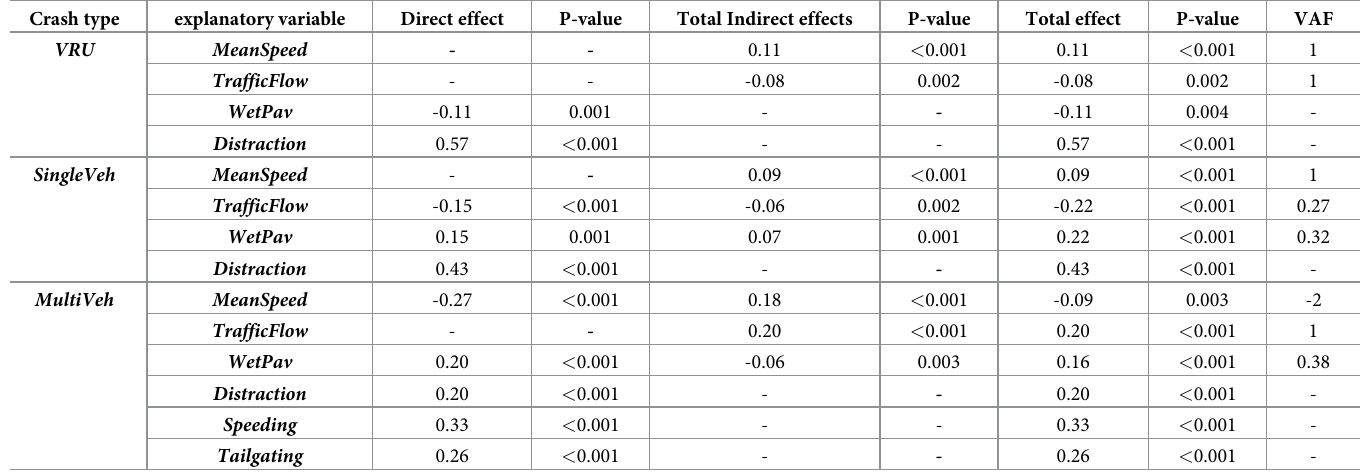
Table 4. Direct, indirect, and total effects of explanatory variables on different crash types. Crash